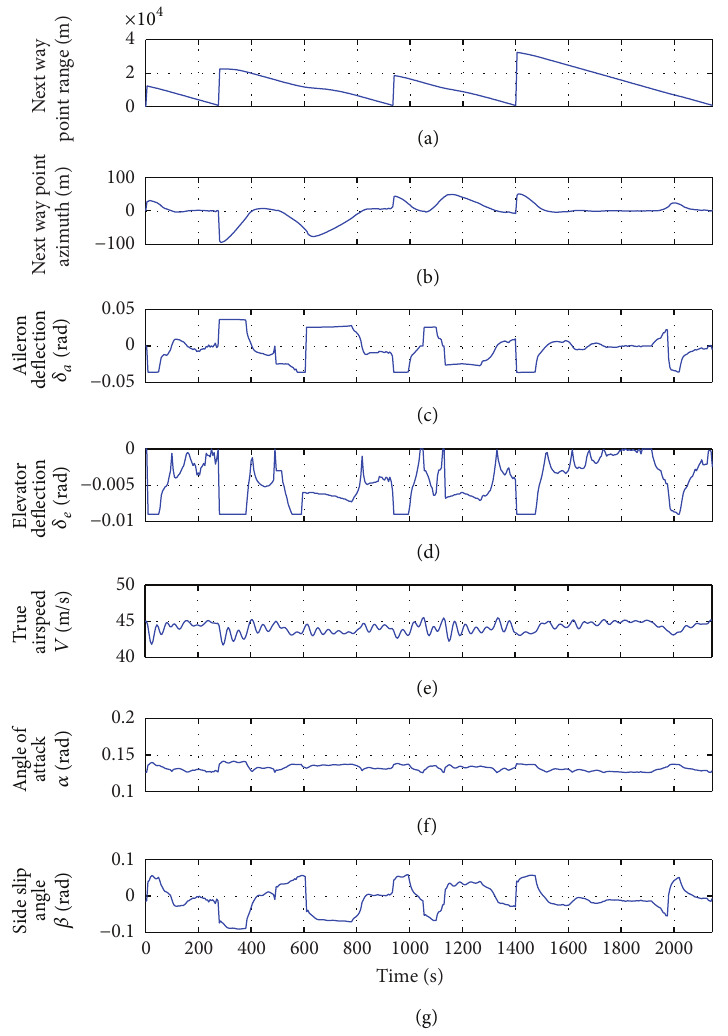
Figure 13: Signals playback for obstacle avoidance simulated